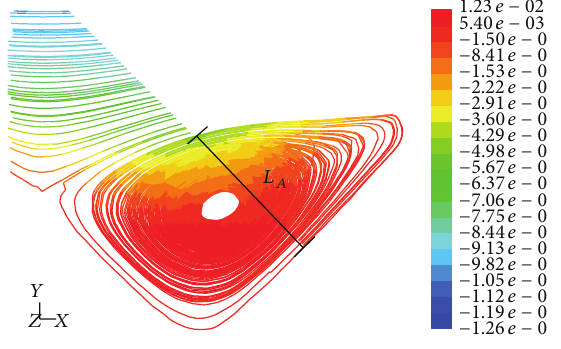
Figure 9: The length of reflux at point A. Table 1: The length of refluxes 𝐿